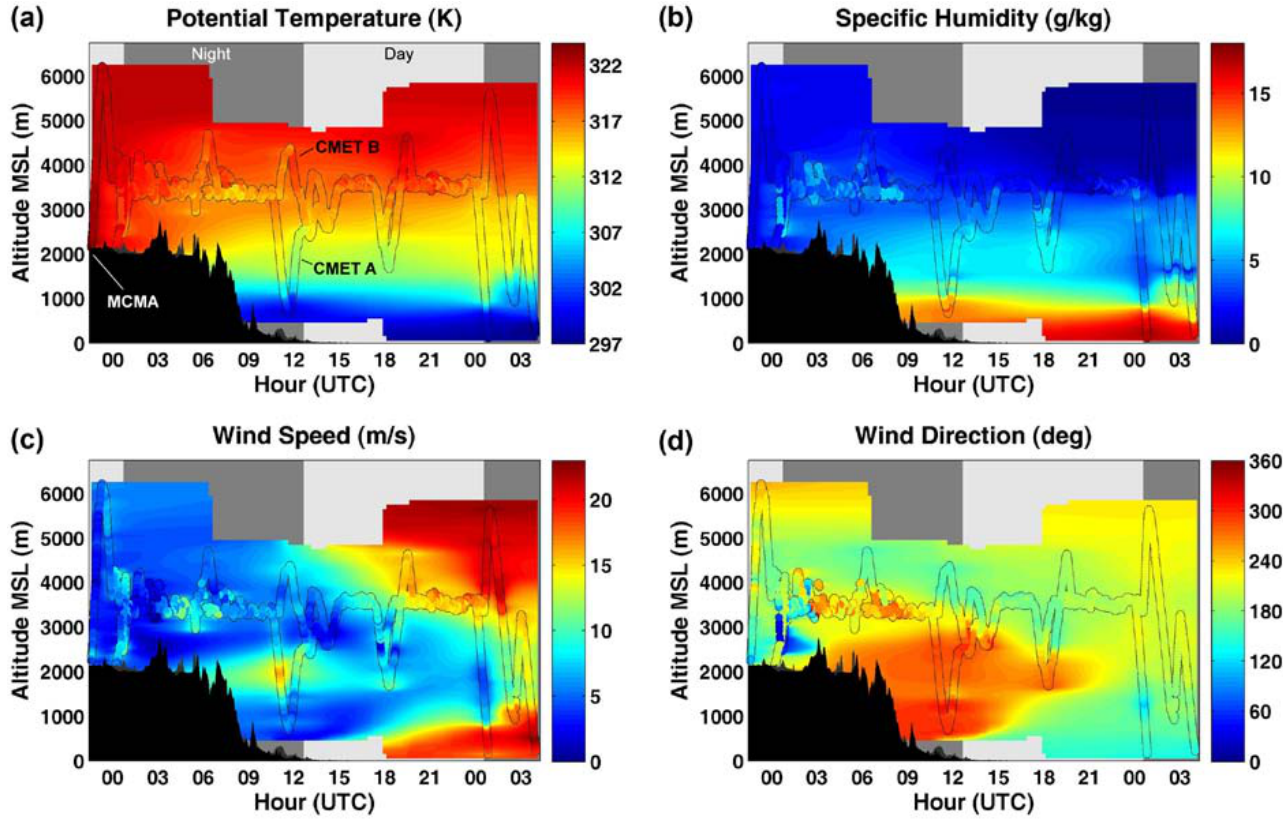
Fig. 10. Potential temperature (a) , specific humidity (b) , wind speed (c) , and wind direction (d) interpolated from the CMET balloon measurements on 18–19 March. The balloon trajectories, labelled CMET A and CMET B in the upper left plot, contain within them the in-situ measurements as color spectra. The background color fields are inverse-square weighted interpolations of the balloon data (see text). Day and night are denoted by the underlying grey shading and the terrain is shown in Figure 10. Potential temperature (a), specific humidity (b), wind speed (c), and wind direction 3 (d) interpolated from the CMET balloon measurements on 18-19 March. The balloon 4